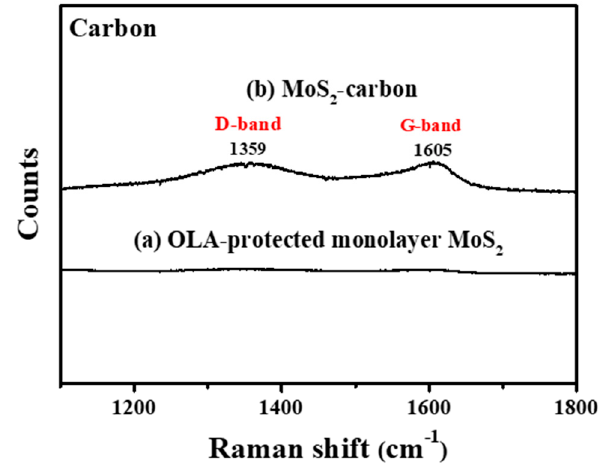
Figure 3. Raman spectroscopy of ( a ) OLA-protected monolayer MoS 2 and ( b ) MoS 2 -carbon.